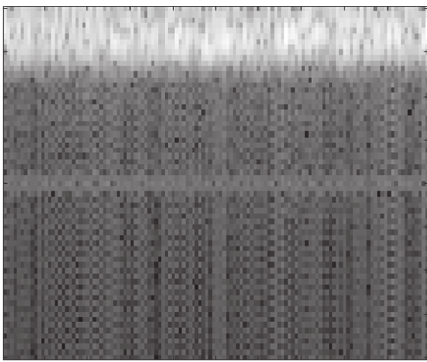
Figure 4: TFG of the vibration